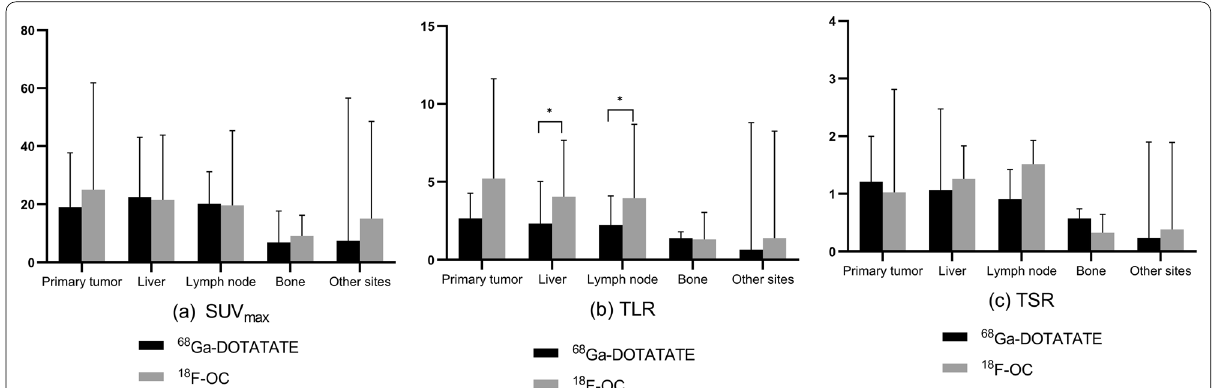
Fig. 4 Bar chart representing the maximum standardized uptake value (SUV max, a ), tumor-to-liver ratio (TLR, b ) and tumor-to-spleen ratio (TSR, c ) of 18 F-OC. TLR ( b ) and TSR ( c ) were calculated by dividing the SUV max of tumor lesions by the patient-specific SUV mean of the liver and spleen, respectively. The TLRs for lesions in the liver and lymph nodes were significantly higher with 18 F-OC ( p SUV max , TLR and TLR calculations did not show significant